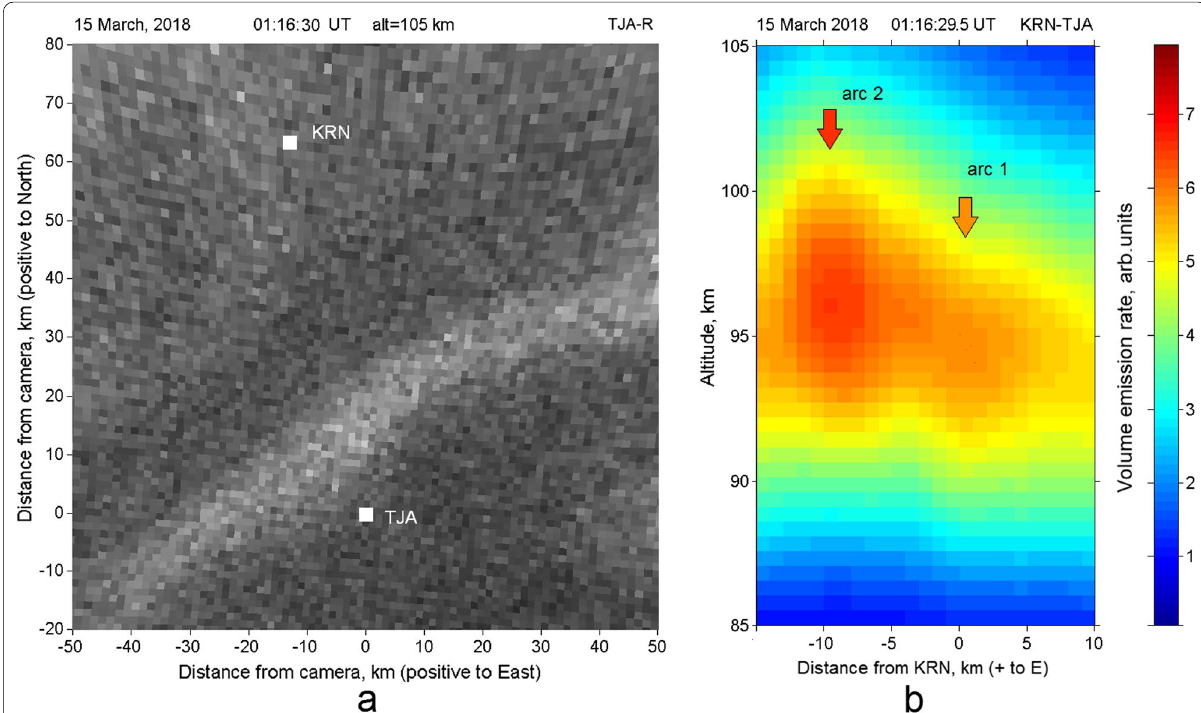
Fig. 5 a Auroral arc shape and location inferred from the TJA‑R image; b tomographic reconstruction of the arc showing its multiple